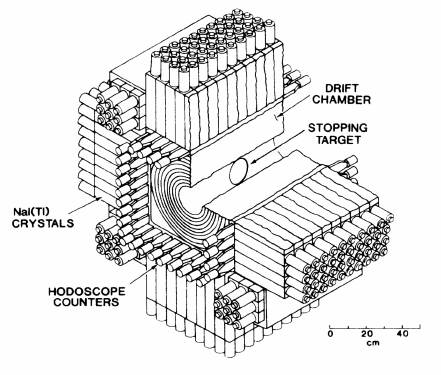
Figure 11. Schematic of the Crystal Box experiment (Figure from